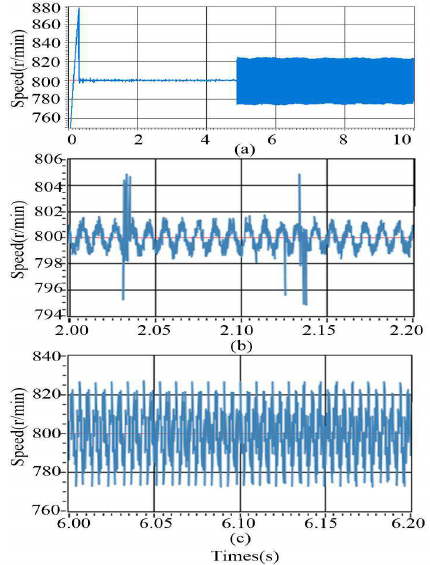
Figure 34. The observed speed using PI at 800 r/min. ( a ) The overall response diagram of observed speed at 800 r/min. ( b ) Observed speed under no load. ( c ) Observed speed under 2 N